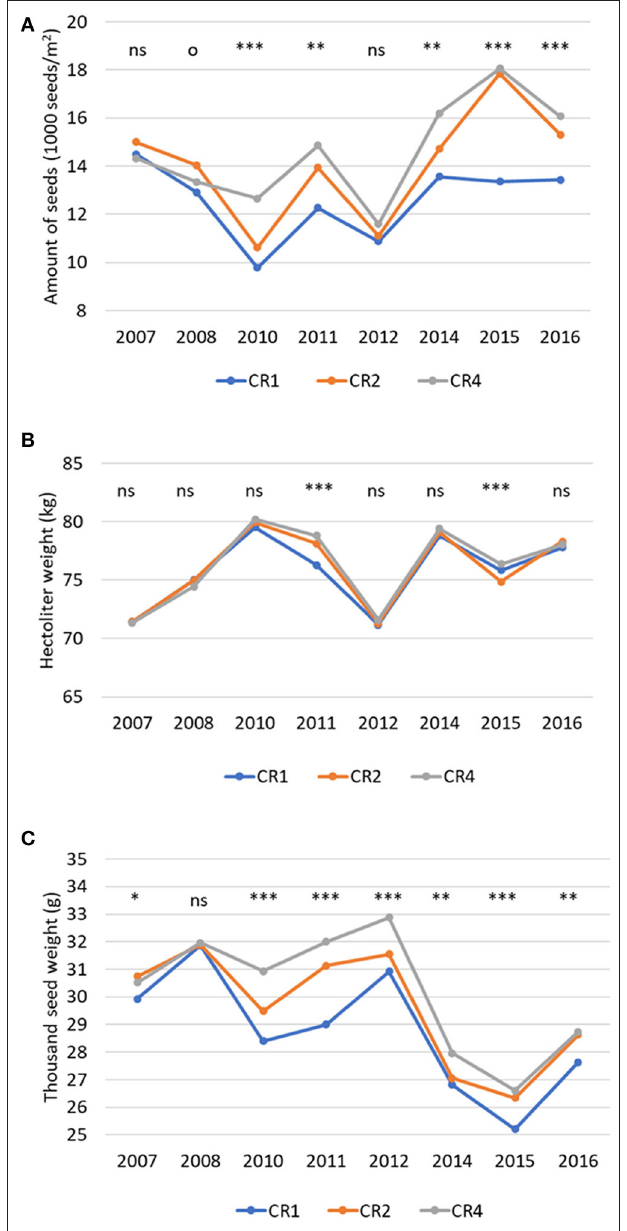
FIGURE 2 | The average number of produced seeds (1,000 seeds/m 2 ) (A) , the hectoliter weight (kg) (B) , and 1,000 seed weight (g) (C) in spring wheat in different years and crop rotations. CR1, wheat monoculture; CR2, wheat every 2nd year; CR4, wheat every 4th year. Statistically significant differences: ns = not significant, o p < 0.10, * p < 0.05, ** p < 0.01, *** p <